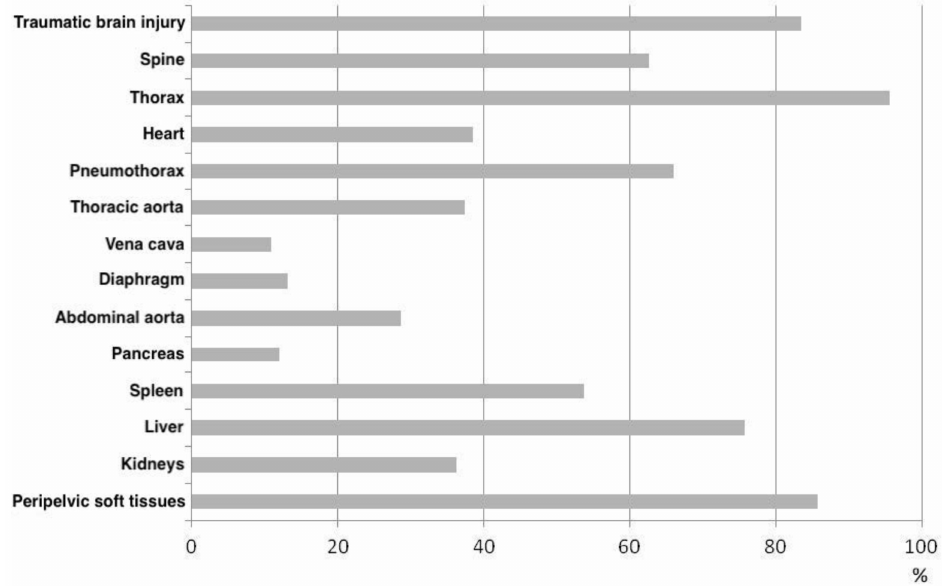
Figure 5. Summary of injury distribution in deceased patients with unstable pelvic injury: almost all patients showed thoracic injuries (96%, n = 87): 66% of patients (n = 60) had pneumothorax, 39% (n = 35) cardiac injury. Traumatic brain injury was documented in 84% (n = 76). Injuries to the spine in 63% (n = 57). 76% of patients (n = 69) showed injury to the liver, 54% (n = 49) to the spleen. Renal and pancreatic injuries were less frequent with 36% (n = 33) and 12% (n = 11), respectively. Diaphragmatic ruptures as a sign of extensive two-cavity trauma were detected in 13% of the collective (n = 12). In 37% of patients (n = 34), an injury to the aorta was found, in 29% (n = 26) of the thoracic aorta. In contrast, the superior or inferior vena cava was injured in 11% (n = 10). Peripelvic soft tissue damage was evident in 86% of the studied collective (n = 78). In 11% of the population (n = 10), the condition of the peripelvic soft tissues was not documented in the autopsy protocols (source: Haussmann [22],